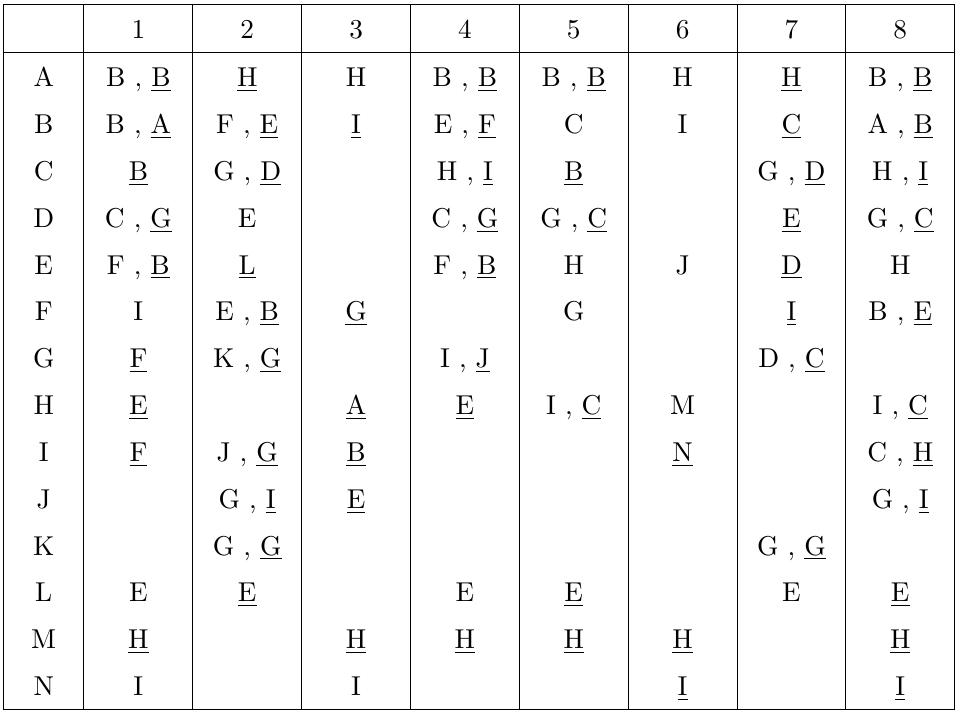
Table 4. Triality connections between the 14 toric phases of Q 1 ; 1 ; 1 = Z 2